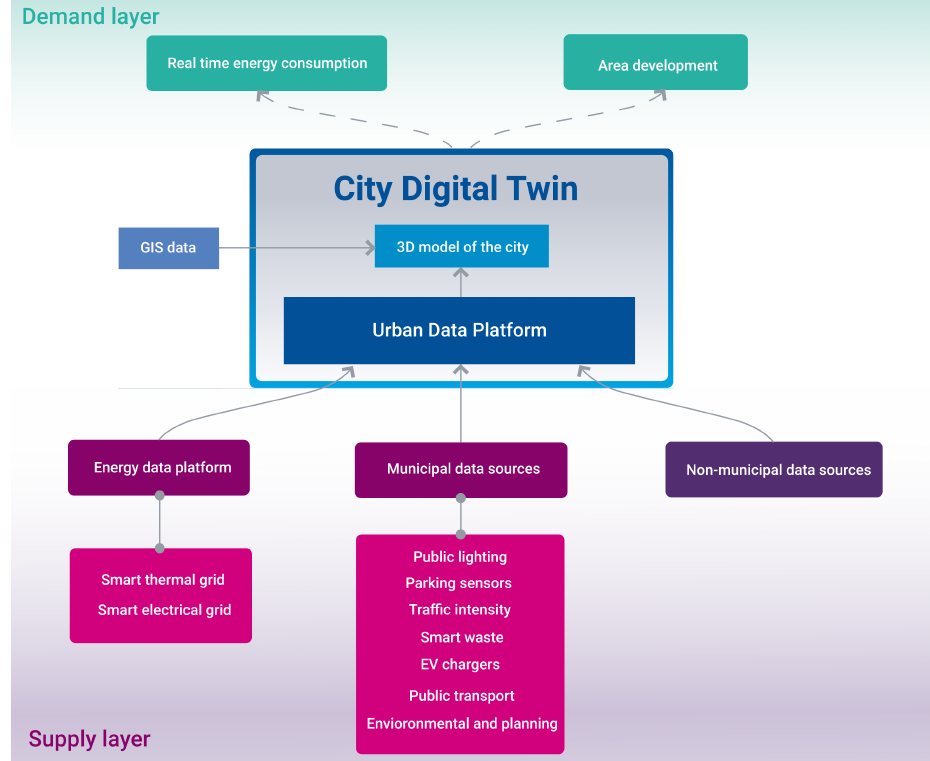
Figure 2. Platform of the city digital